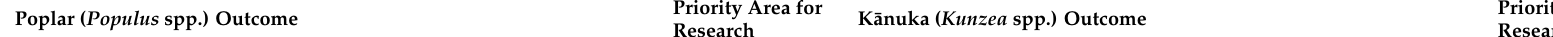
Table 3. Silvopastoral outcomes for poplar ( Populus spp.) and k¯anuka ( Kunzea spp.) in a New Zealand hill country silvopastoral system. Tree outcomes have been adapted from Wood [15]. Silvopastoral